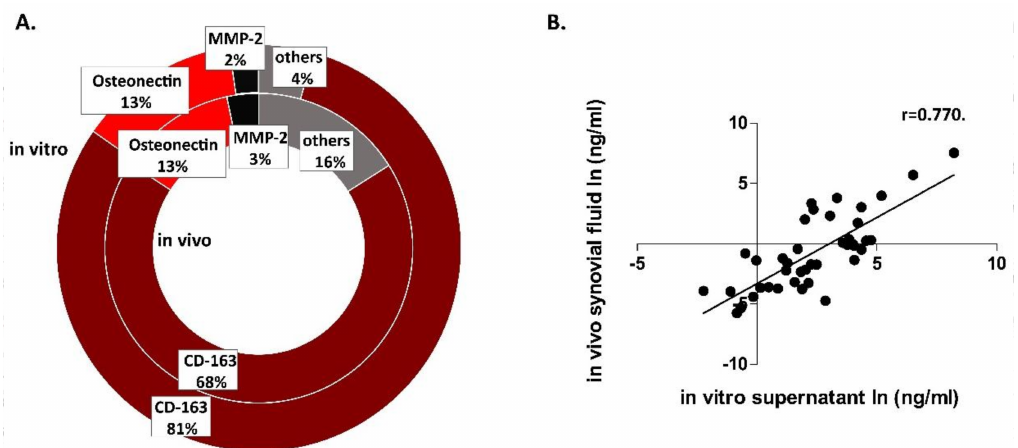
Figure 3. Cytokine pattern comparison. The measured 39 cytokines were present both in vivo and in vitro in a similar distribution. The highest concentrations were measured in the case of cluster of di ff erentiation 163 (CD163), osteonectin, and matrix metalloproteinase-2 (MMP-2) both in vitro and in vivo ( A ). After transforming the dataset, we found a very strong correlation between the cytokine content of the in vitro and in vivo samples: n synovial fluid = 19, n supernatant = 12 ( B ).